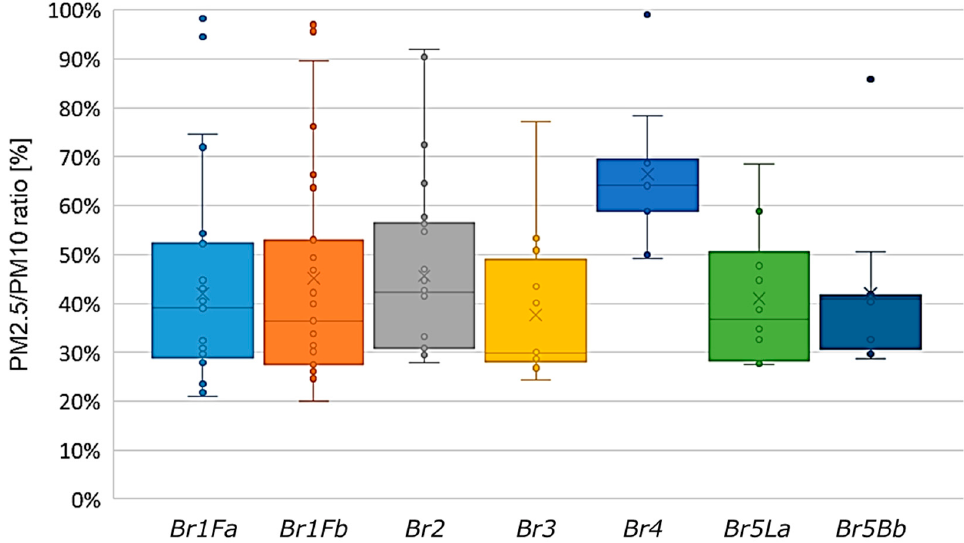
Figure 4. Overview of the PM2.5 to PM10 emissions ratio for all brakes. The minimum, first quartile, median (denoted with the horizontal line), average (denoted with the “ × ”), third quartile, and maximum statistical variables are included in the chart. Outliers are denoted,